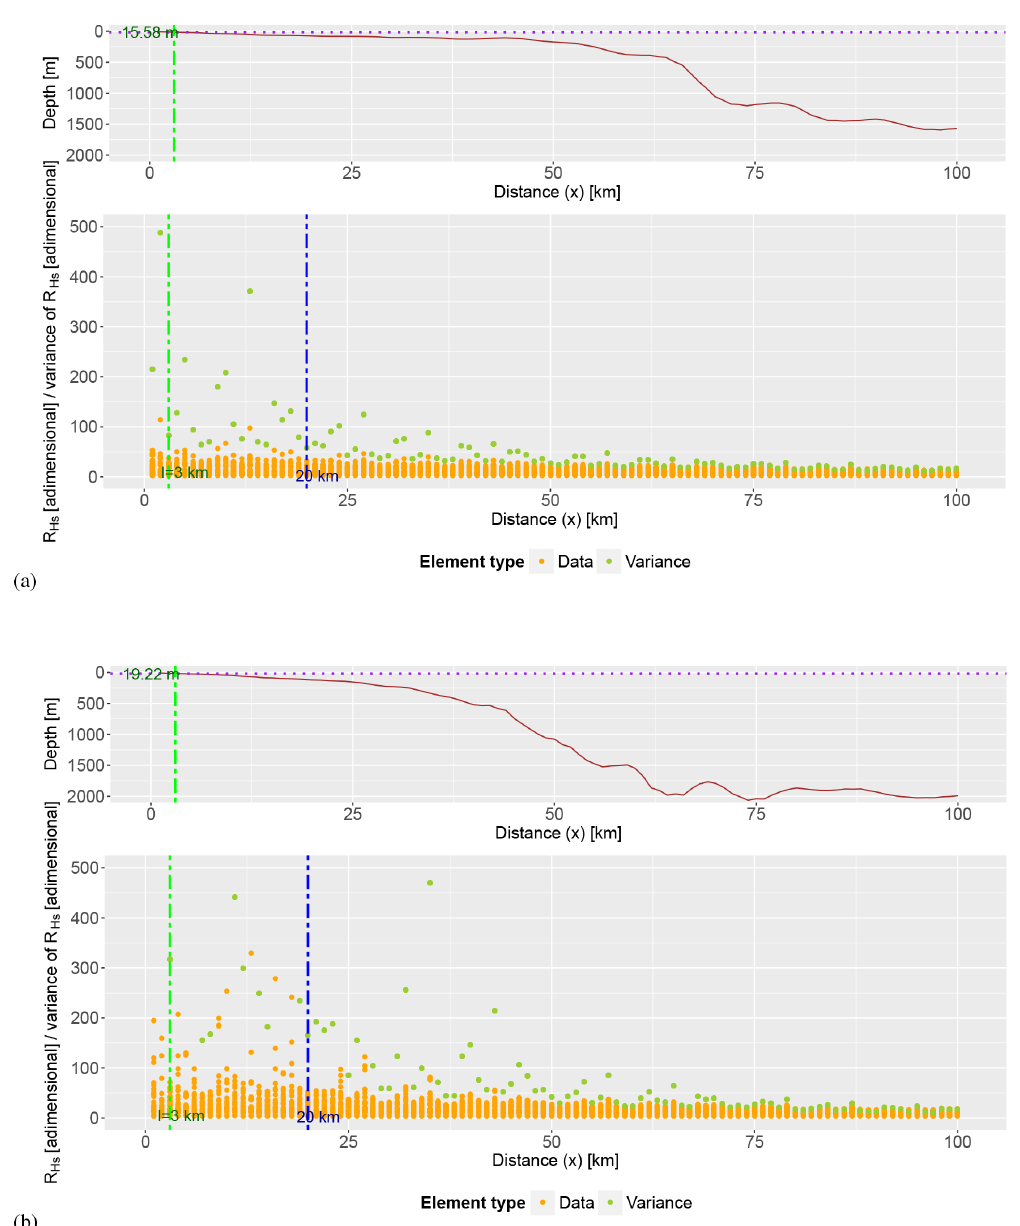
Figure 8. Relation for winter conditions (February 2017) between distance to the coast x , depth and anisotropy ratio of significant wave height ( R H ) from shore to 100km offshore. Locations are (a) south control transect (near the Ebro Delta) and (b) central-north transect s (near Mataró harbour). The distance of 20km, which has been suggested as an approximate order of magnitude limit for direct applicability of remote-sensing data, is also shown (dashed blue line) together with the variance in R H anisotropy-based boundary has been calculated and is also depicted. A dash-dotted green line delimits its horizontal distance from the coast, whereas a dotted purple line denotes its